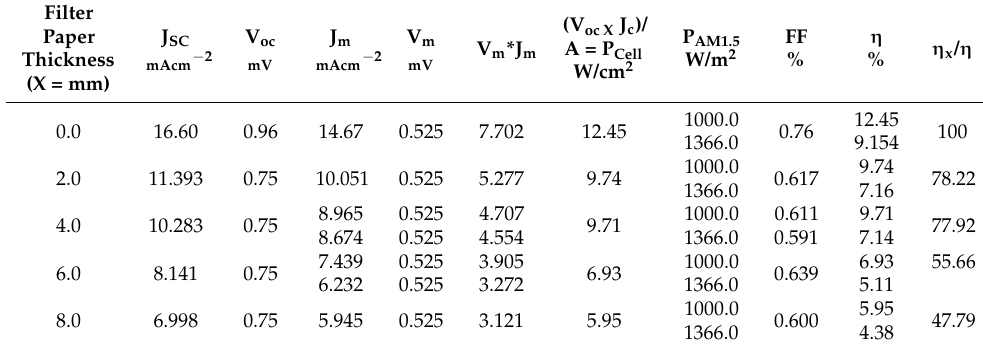
Table 2. DSSC Photovoltaic parameters at various filter paper thicknesses and light